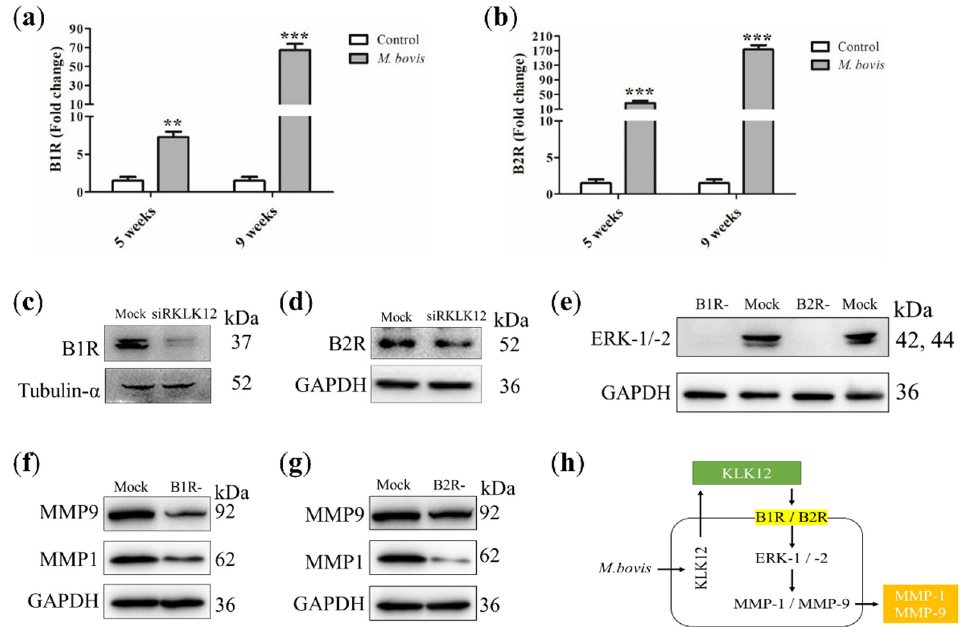
Figure 2. Blocking BR downregulates ERK and MMP-1/-9 expression. Mice ( n = 10) were intranasally infected with M. bovis (at a dose of 200 CFU/mice) or with PBS. Mice were sacrificed after 5 and 9 weeks of infection, and lung tissues were collected. ( a ) B1R and ( b ) B2R expression was determined by Quantitative Real-Time PCR (qRT-PCR). RAW264.7 cells were transfected with siRKLK12 and negative control siRNA (20uM). After 48 h of transfection, the cells were infected with M. bovis . After 24 h, samples were collected. Then, ( c ) B1R and ( d ) B2R expression was determined by Western Blot analysis. To validate our hypothesis, RAW264.7 cells were processed to block bradykinin receptors and infected with M. bovis . After 24 h, samples were collected. ( e ) ERK-1/-2 and ( f , g ) MMP-1/-9 expression was determined by Western Blot analysis. ( h ) The regulation of MMP-1/-9 expression by M. bovis through the BR/ERK signaling pathway is represented schematically. Data represent the mean ± SD of three independent experiments (** p < 0.01; *** p <